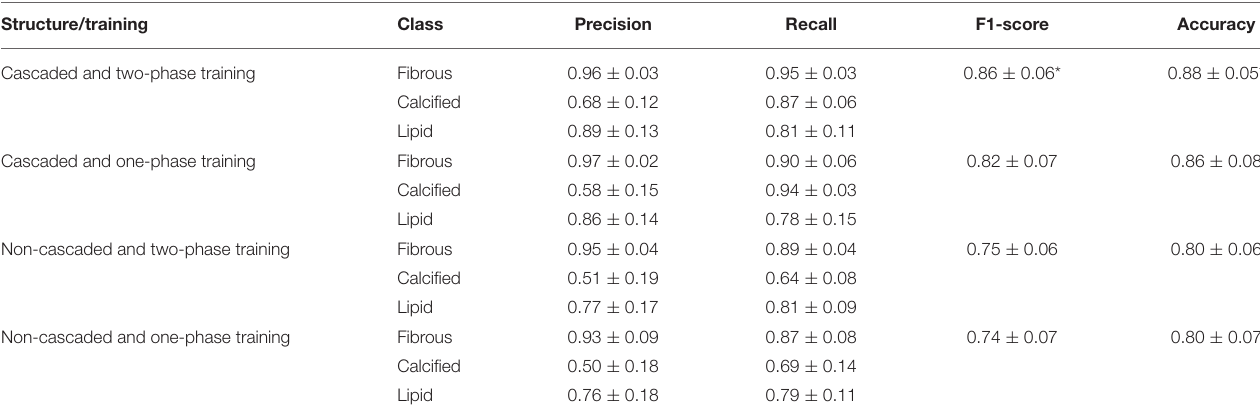
TABLE 2 | The confidence interval of performance with or without training strategies (cascaded structure and two-phase training). Structure/training